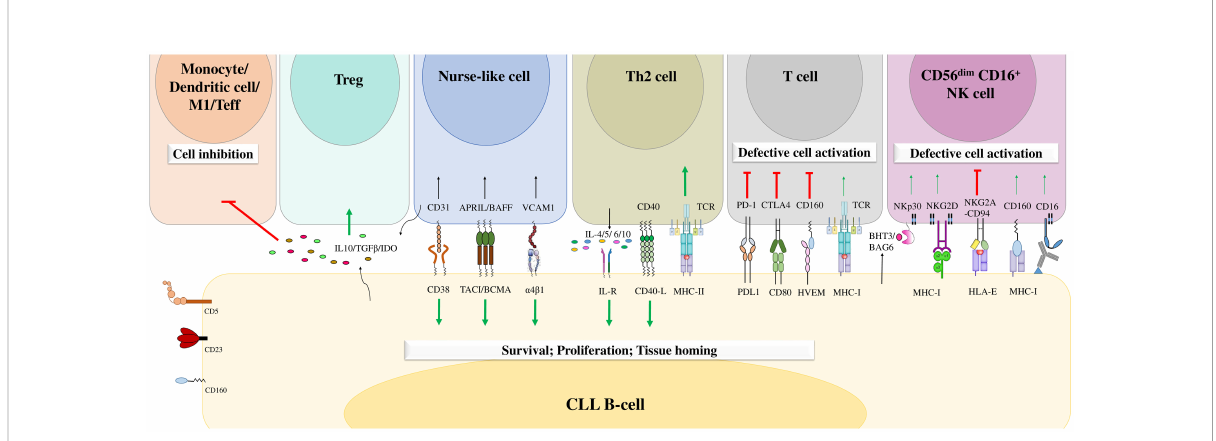
FIGURE 4 The B-cell chronic lymphocytic leukemia microenvironment. CLL cells engage in crosstalk with different cells in the microenvironment through different molecular interactions or through the release of soluble factors. This crosstalk favors the delivery of activating signals to promote CLL B-cell survival, proliferation, and tissue homing and decreases the numbers of cytotoxic immune cells, leading to tumor cell escape from immune surveillance. Adapted from (36,